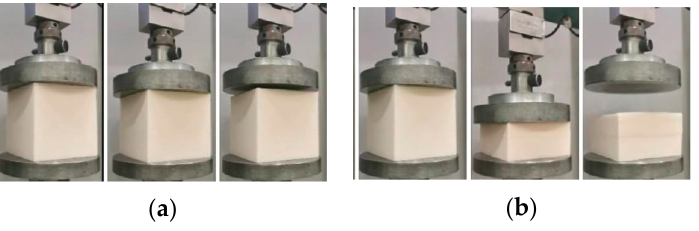
Figure 9. Compression-cycle press/hold/release; ( a ) 10% deformation, ( b ) 50% deformation.